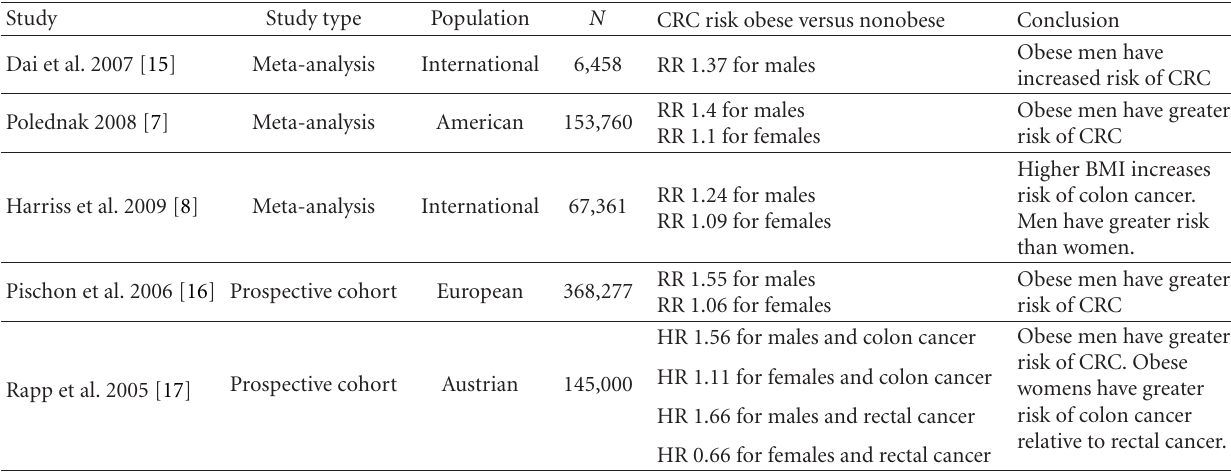
Table 1: Obesity and risk of developing colon